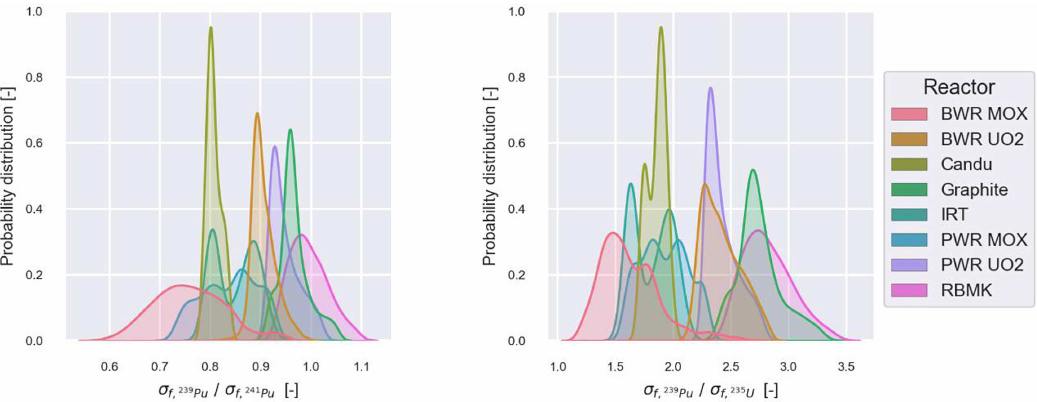
Fig. 1. Distribution of the effective fission cross-section ratio of (left) 239 Pu to 241 Pu, and (right) 235 U to 239 Pu for all cases of the assessment database. A distribution plot according to the reactor type was deemed sufficient, in view of a limited dependence of those ratios with assembly design, enrichment, water density or